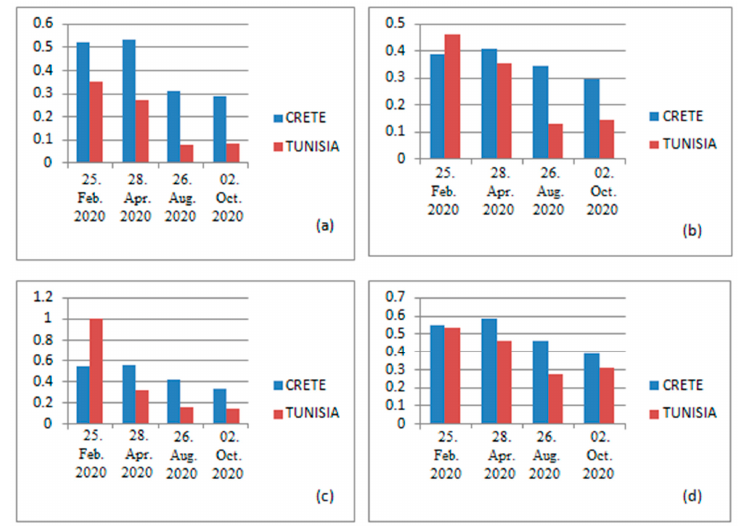
Figure 6. NDVI and NDWI mean values of OMW disposal sites for Tunisian and Greek studies areas; ( a ): NDVI mean values of wastes areas using Sentinel-2, ( b ): NDWI mean values of wastes areas using Sentinel-2, ( c ) NDVI mean values of wastes areas using PlanetScope, and ( d ): NDWI mean values of wastes areas using PlanetScope. In the following charts, the results of relative differences of spectral indices were evaluated. Concerning Sentinel-2, the NDVI, NDWI, and DI show high sensitivity values between OMW disposal sites and their neighborhood areas (the difference is greater than 30%) for both study areas during February and April rather than August and October. PlanetScope imagery also shows equivalent responses compared to the Sentinel-2 results on both areas of study. Nonetheless, the calculated NDVI, NDWI, and DI revealed higher reflectance differences between each OMW site and its adjacent area during February and April (decreased in August and October).Thus, these are considered to be the optimum indices for enhancing the contrast between the inner and the outside parts of OMW dis- posal areas for both case studies. In addition, the sensitivity of PlanetScope seems to be more promising compared to Sentinel-2 (i.e., the difference of DI reaches 70% for Plan- etScope and 50% for Sentinel-2 in the Greek case study) (Figure 7).